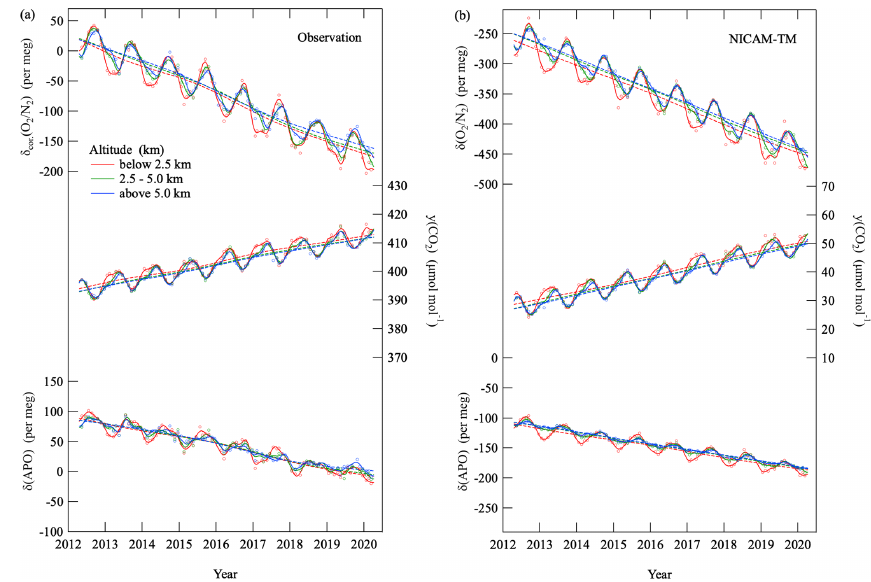
Figure 5. (a) δ cor . (O 2 / N 2 ), the CO 2 amount fraction and δ (APO) observed in the troposphere over MNM at various altitudes. Best-fit curves to the data (solid lines) and secular trends (dashed lines) are also shown (Nakazawa et al., 1997a). (b) Same as in (a) but for calculated values using NICAM-TM. The data from NICAM-TM are reported on arbitrary scales different from those of